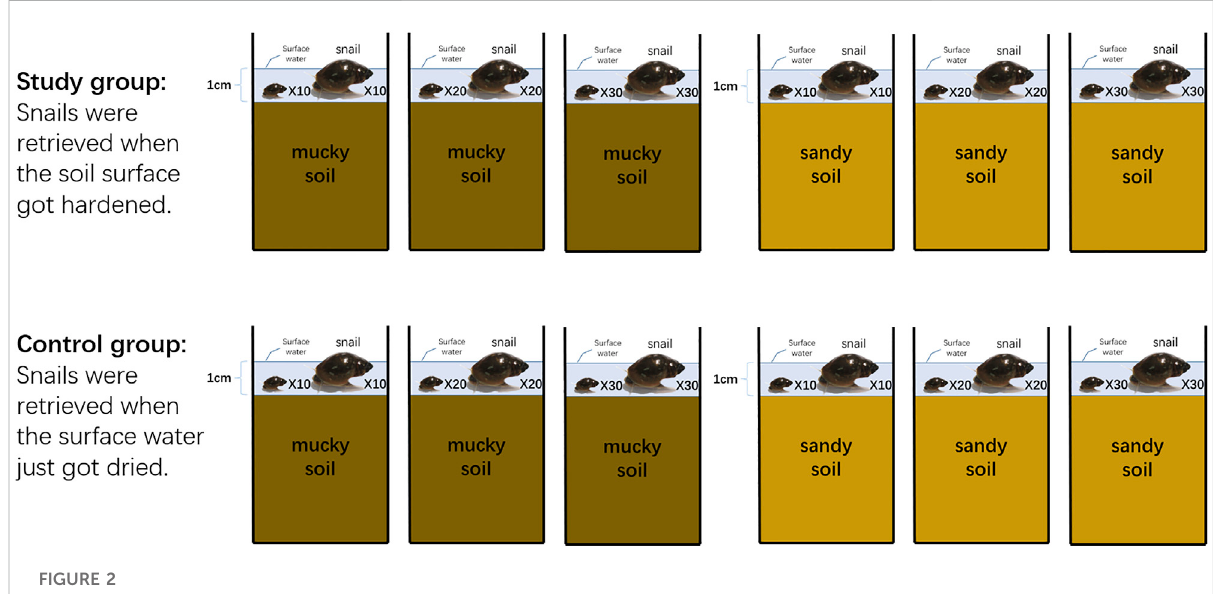
FIGURE 2 Experimental design for the downward movement of B. globosus snails in drying soils.